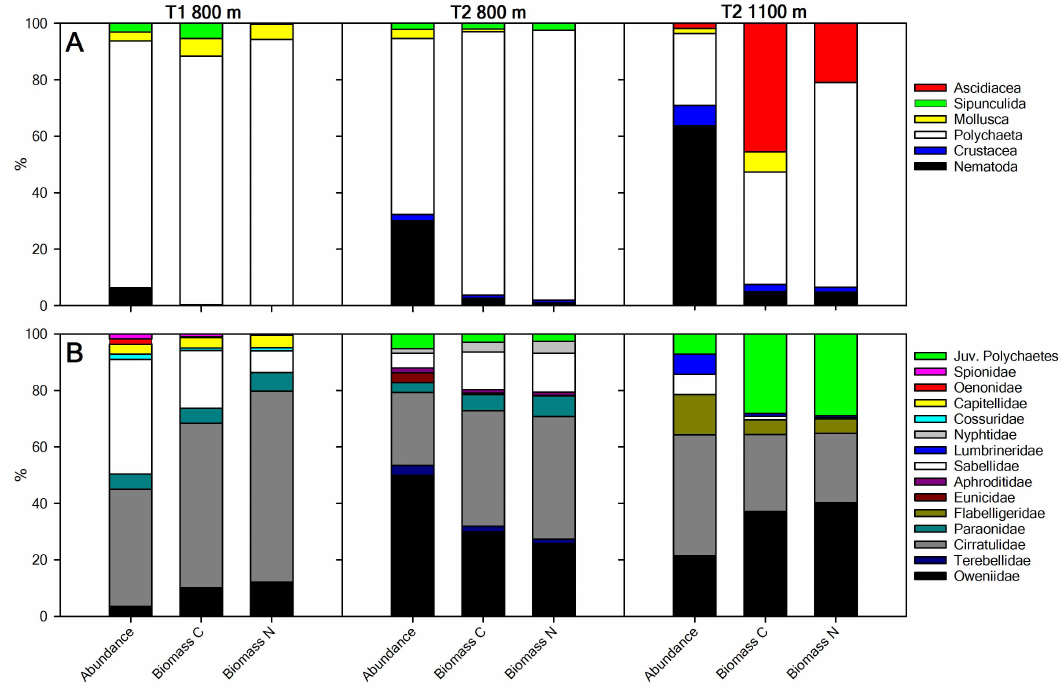
Fig. 3. Relative abundance, biomass C and biomass N of (A) the major macrofaunal taxa and (B) the polychaetes families at stations T1 800m, T2 800m and T2